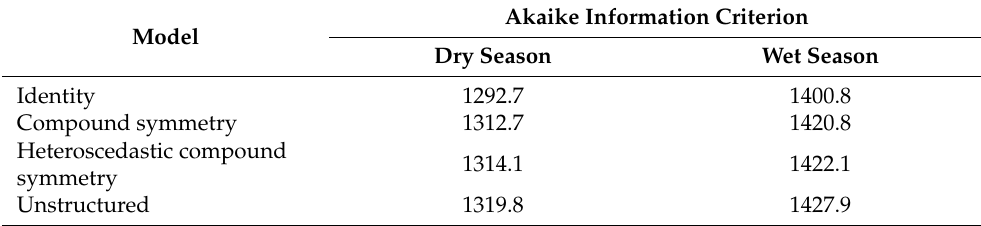
Table 4. Akaike information criterion (AIC) for variance–covariance structures fitted to cultivars by crop rotation models.